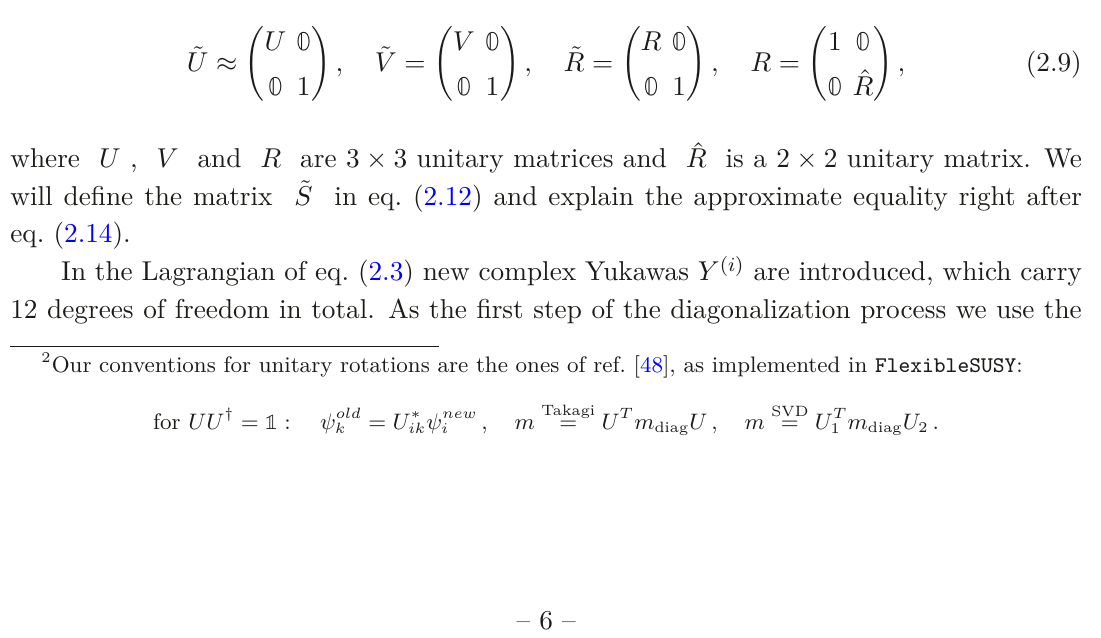
figure 1. To find the physical neutrino states and their masses, one has to include one-loop corrections and diagonalize the mass matrix by unitary transformations.